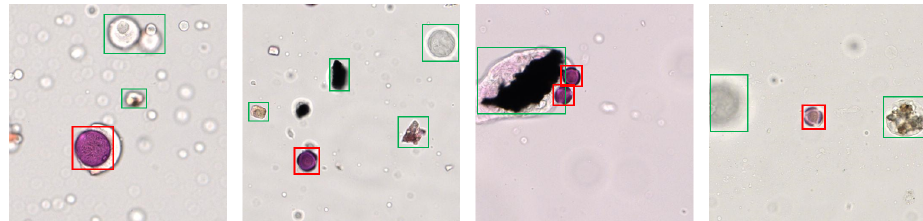
Figure 1. Several images (with a size of 512 × 512) that were cropped from pollen scanning images. The pollen grains are marked in red and background noise is marked in green (i.e., air bubbles, debris and dust).